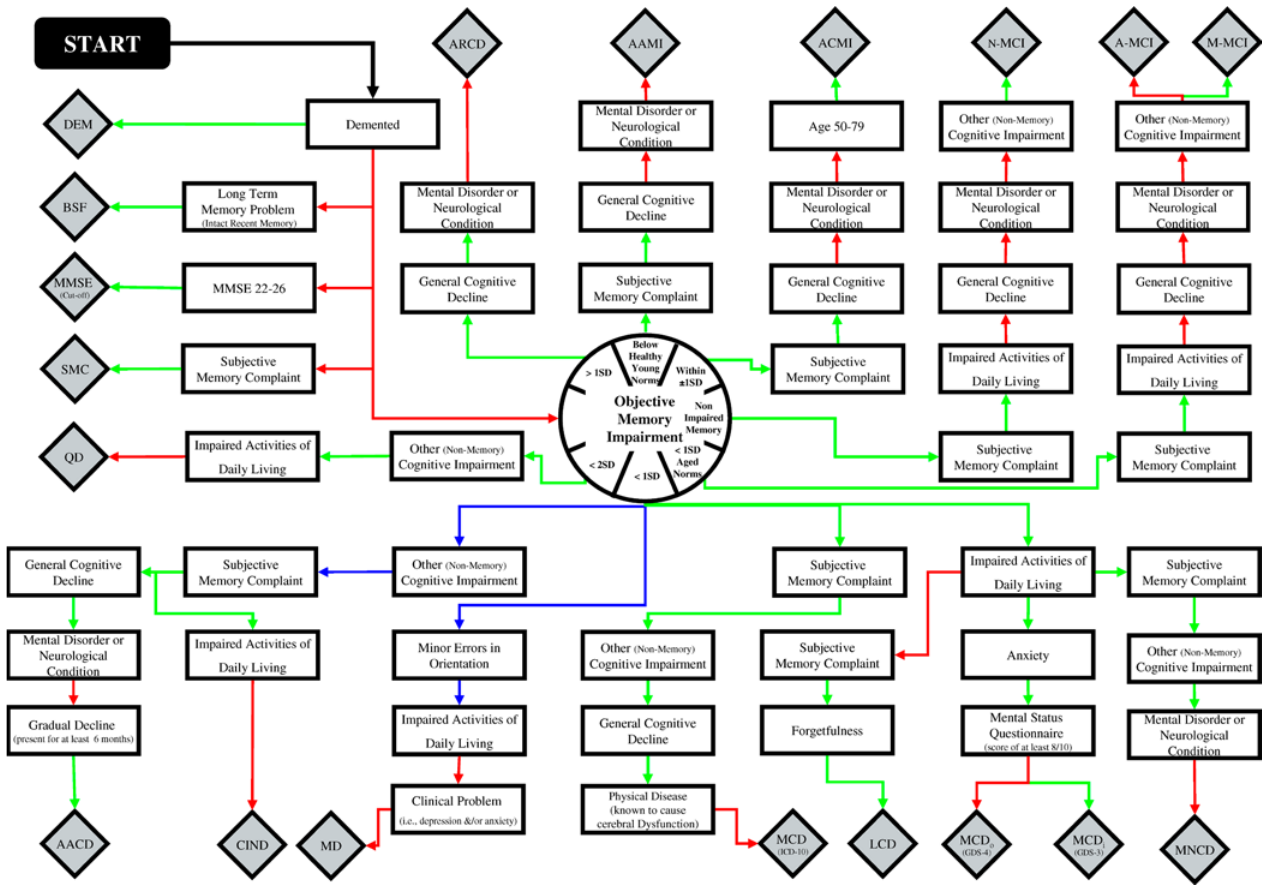
Figure 1. Schematic Overview of the Approach Used to Classify MCI across Different Definitions in the Medical Research Council Cognitive Function and Ageing Study AACD, age-associated cognitive decline; AAMI, age-associated memory impairment; ACMI, age-consistent memory impairment; ARCD, age-related cognitive decline; CIND, cognitive impairment no dementia; DEM, dementia; LCD, limited cognitive disturbance; MCD (ICD-10), mild cognitive disorder (International Classification of Diseases 10th Revision); MCD (GDS3), mild cognitive decline (Global Deterioration Scale Stage 3); MCD (GDS4), moderate i o cognitive decline (Global Deterioration Scale Stage 4); MD, minimal dementia; M-MCI, multiple mild cognitive impairment; MMSE, Mini Mental State Examination Cut-off Scores; MNCD, mild neurocognitive disorder; N-MCI, non-amnestic mild cognitive impairment; QD, questionable dementia; SD, standard deviation; SMC, self-reported memory